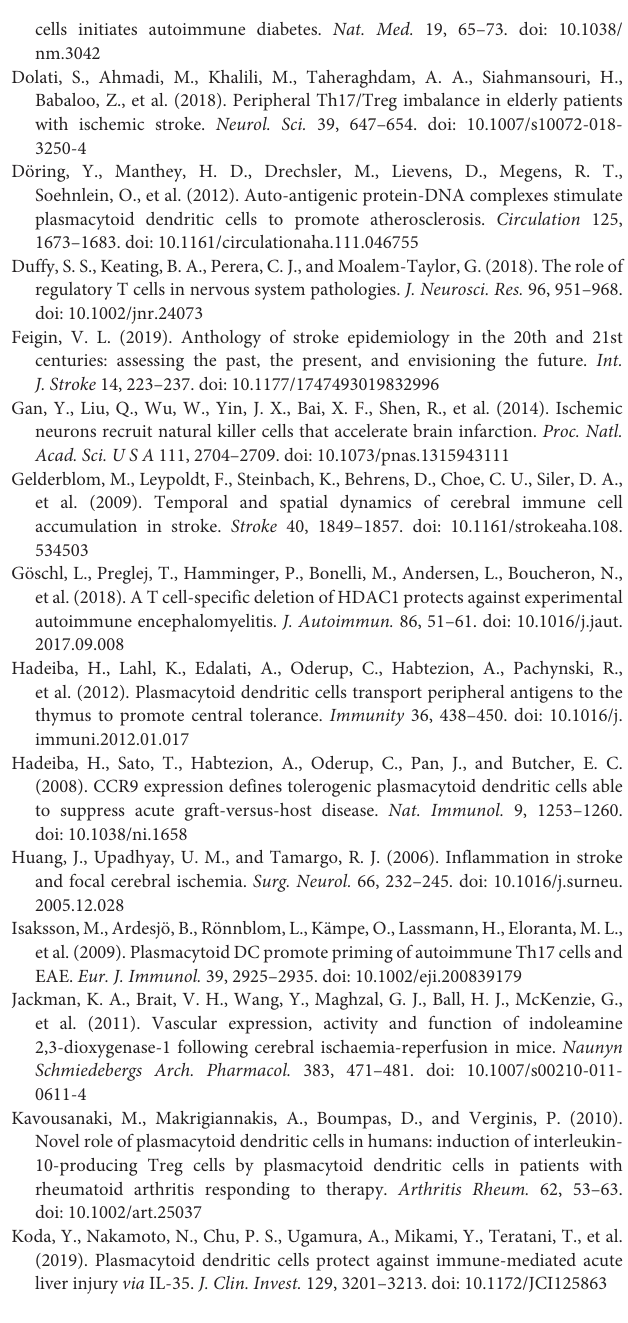
FIGURE S1 | Plasmacytoid dendritic cells (pDCs) lost protective effect in the absence of Tregs. Two-hundred micrograms anti-mouse CD25 mAb i.p.injection was conducted at − 3 and − 1 day, following by 100 µ g 120G8 mAb immediately before middle cerebral artery occlusion (MCAO) or not in mice. Representative TTC images of animals from each group and corresponding statistical analysis. Data are expressed as means ± SEM for n = 4 mice per group. The scatter plots represent independent samples.